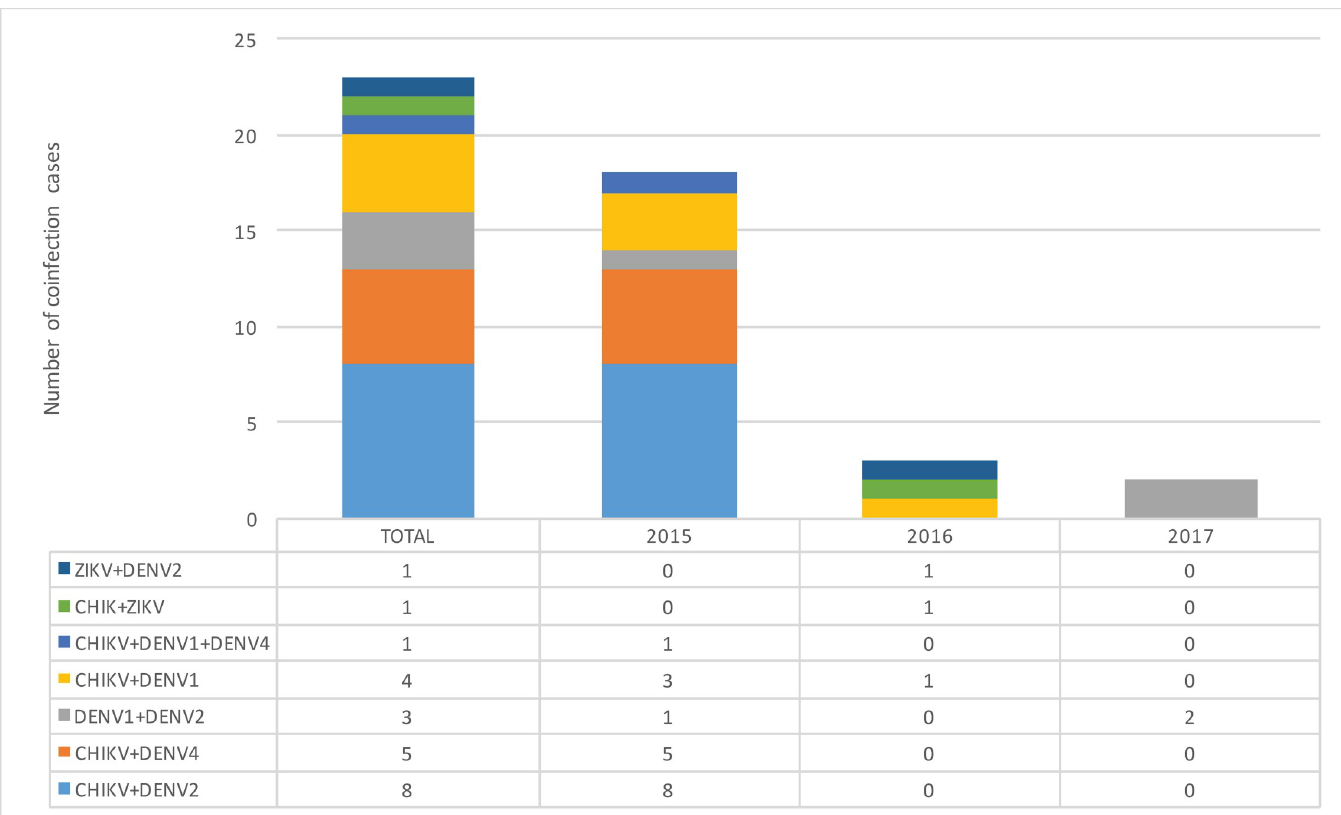
Fig 2. Coinfections detected in the study. The different combinations of viruses identified in cases of coinfection are broken down in the bars during the entire period of study.